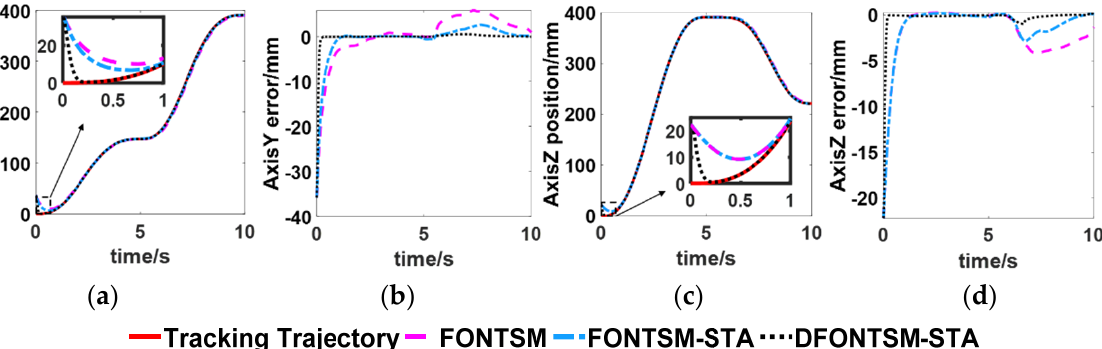
Figure 6. Terminal motion trajectory and its tracking error on Y axis and Z axis of the base coordina-